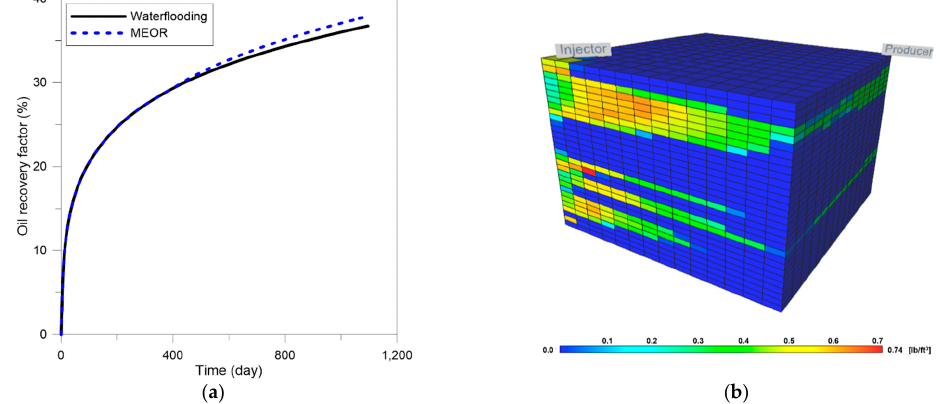
tageous in terms of computation time.